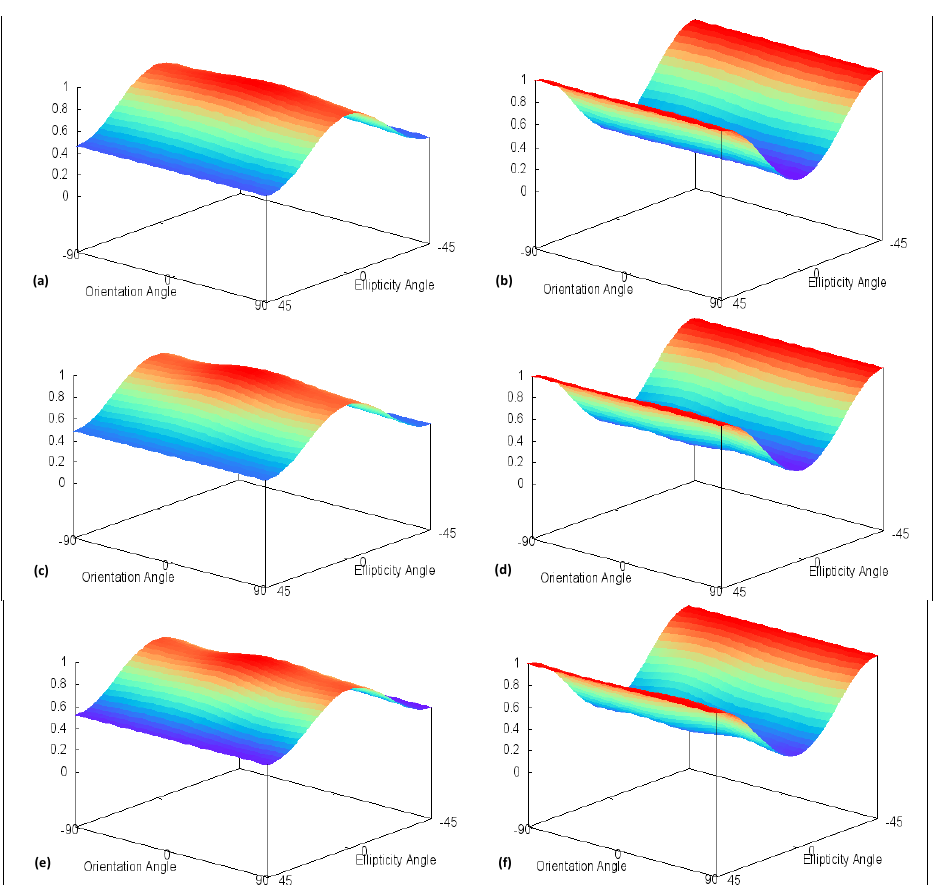
Figure 6. Forest co- ( Left ) and cross-polarization ( Right ) polarimetric response plots based on RADARSAT-2 fine-quad beam modes for 11 July ( a , b ); 7 August ( c , d ); and 24 September ( e , f ).